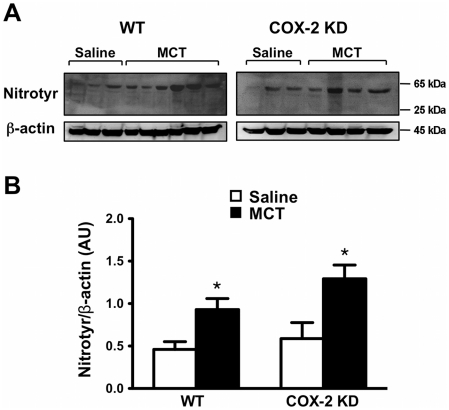
Oxidative stress is exacerbated in lungs after MCT treatment.A. Detection of nitrated tyrosine residues in whole lung homogenates in WT and COX-2 KD mice after MCT administration compared to saline-treated mice. The antibody detected a specific band (Nitrotyr) at ≅65 kDa. β-actin is shown as loading control. Each lane represents lung proteins from one mouse. B. Quantitation of band intensities expressed as ratio with β-actin, in arbitrary units (AU). WT/saline, n = 3; WT/MCT, n = 6; COX-2 KD/saline, n = 3; COX-2 KD/MCT, n = 4. * p<0.05 vs saline.